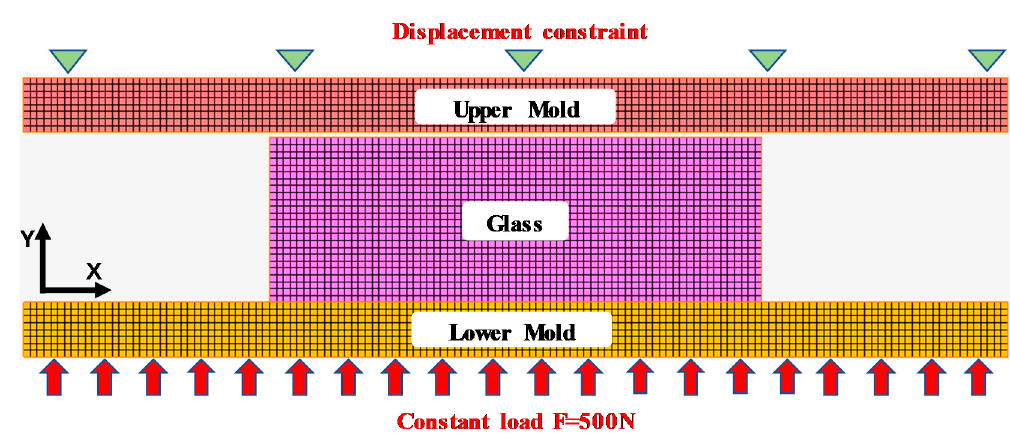
Figure 10. 2D finite element method (FEM) simulation model of the glass cylinder compress. Table 5. Thermodynamic characteristics of glass and mold.